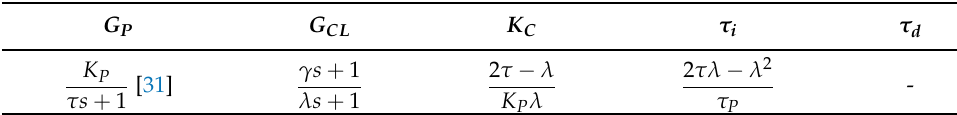
Table 4. IMC—controller tuning